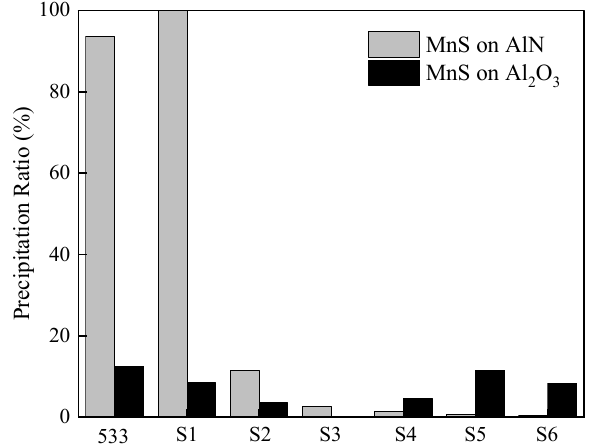
Figure 7. A comparison of the MnS precipitation ratio (PR) values for AlN and Al 2 O 3 inclusions.